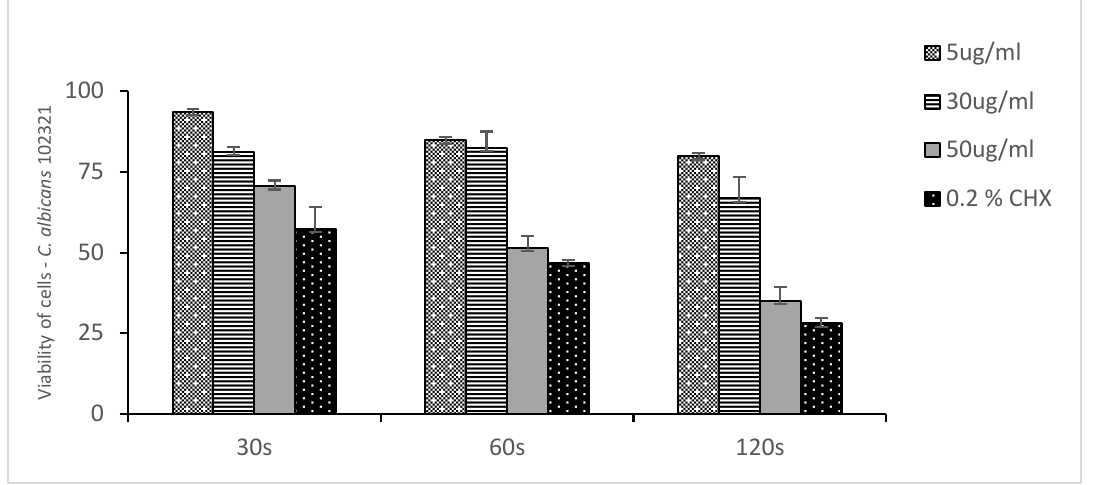
Figure 1. The study design .